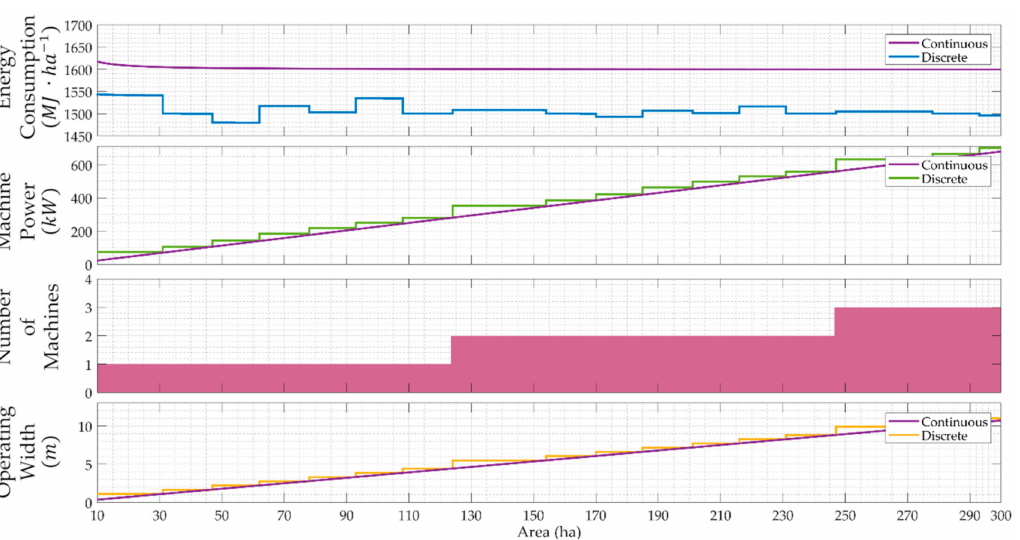
Figure 8. Energy consumption, machine power, number of machines, and operating width for 50 h time available (field cultivator).